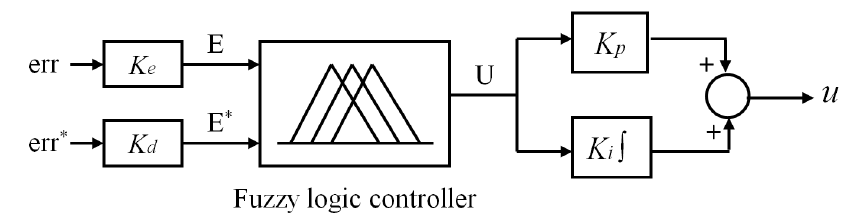
Figure 9. Configuration of fuzzy PID controller.